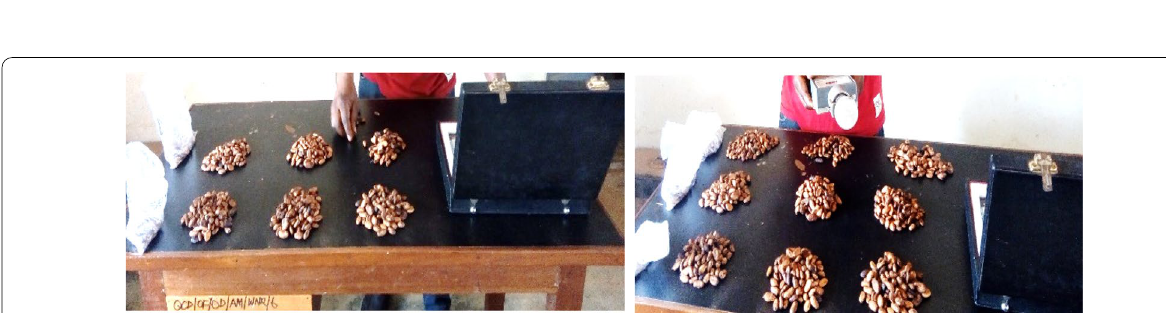
Fig. 2 Bean count and determination of moisture content with moisture meter aquaboy